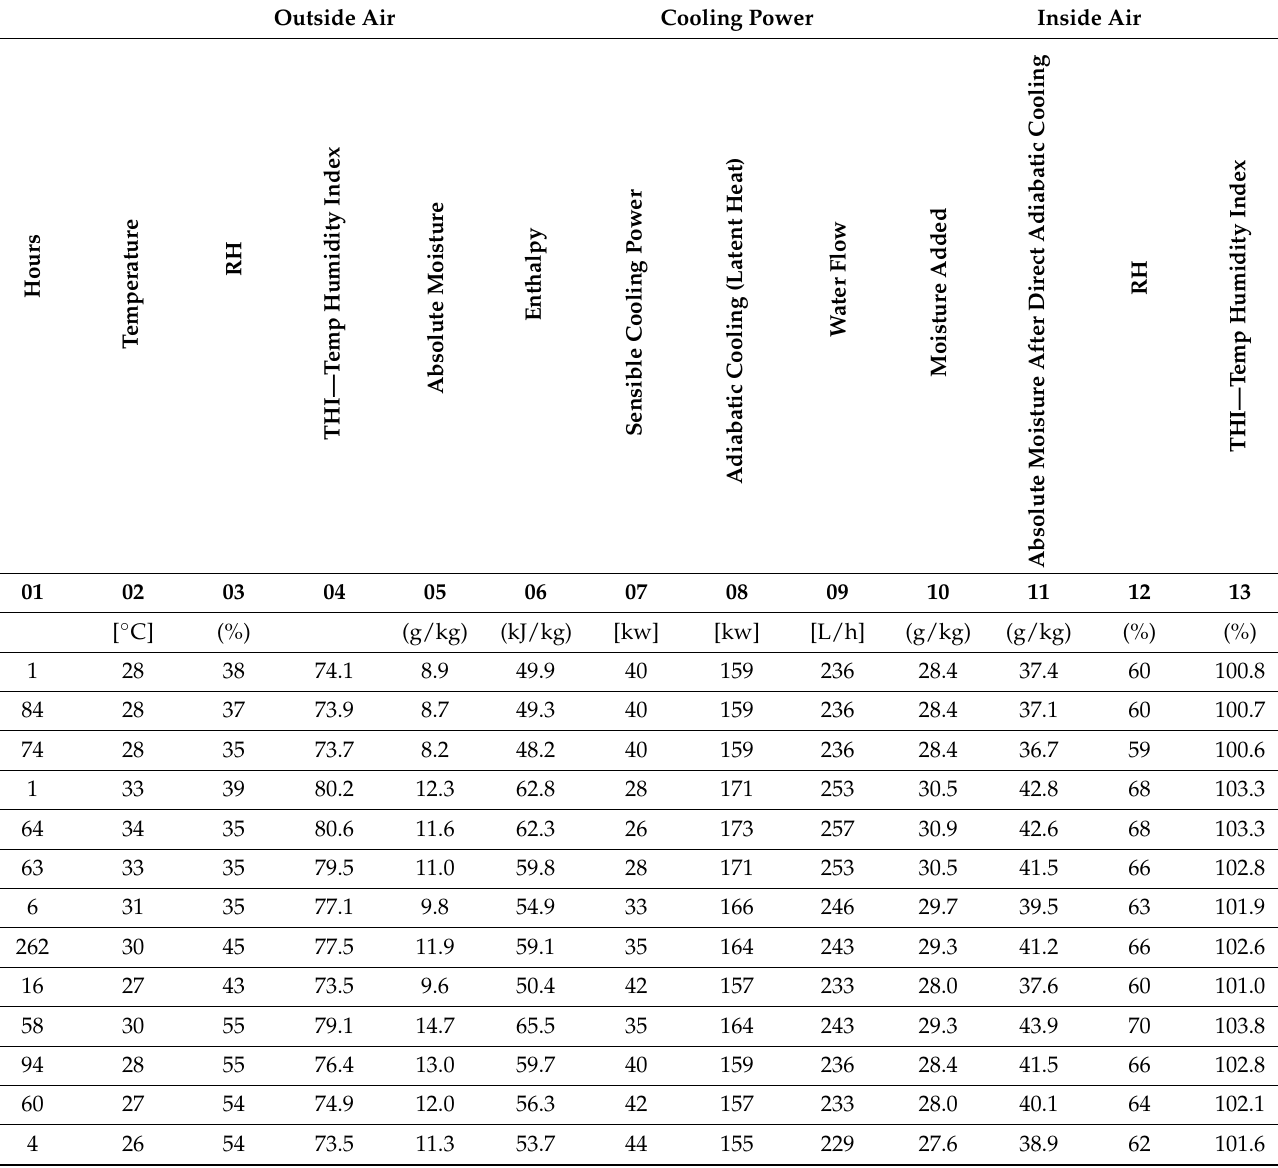
Table 8. THI index, relative humidity, and direct adiabatic cooling power calculated for cooling air flow of 7350 m 3 /h and total air flow of 21.000 m 3 /h (one fan of 8000 and one of 13.000 m 3 /h), inside air temperature 45 ◦ C, RH according to